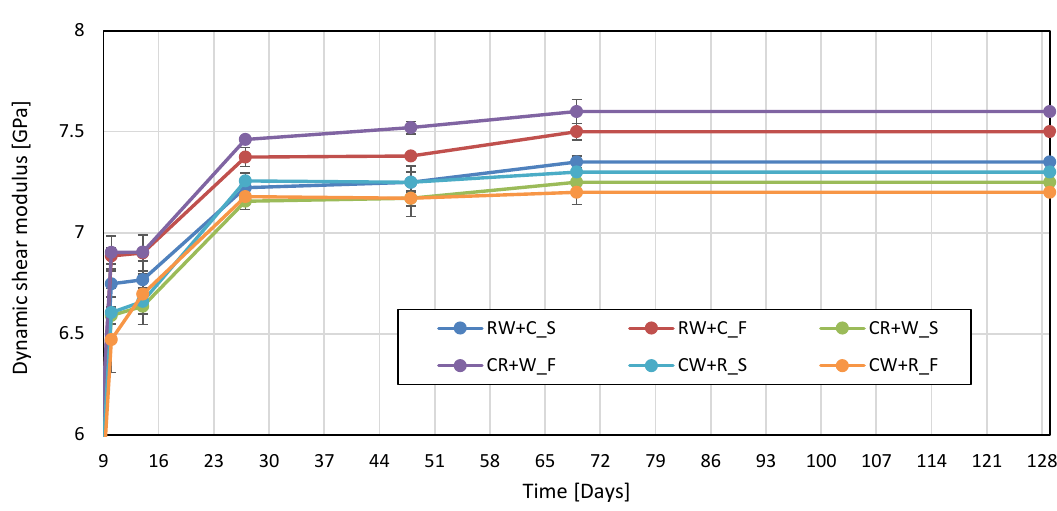
Figure 2. Time dependence of dynamic shear modulus (with standard deviation).